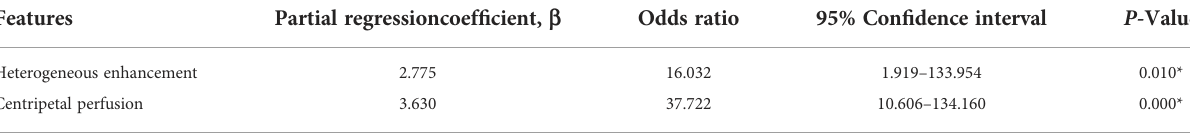
TABLE 4 Multivariate logistic regression analysis of ultrasonographic features related to malignant CCLNs distinguishing from benign CCLNs. Features